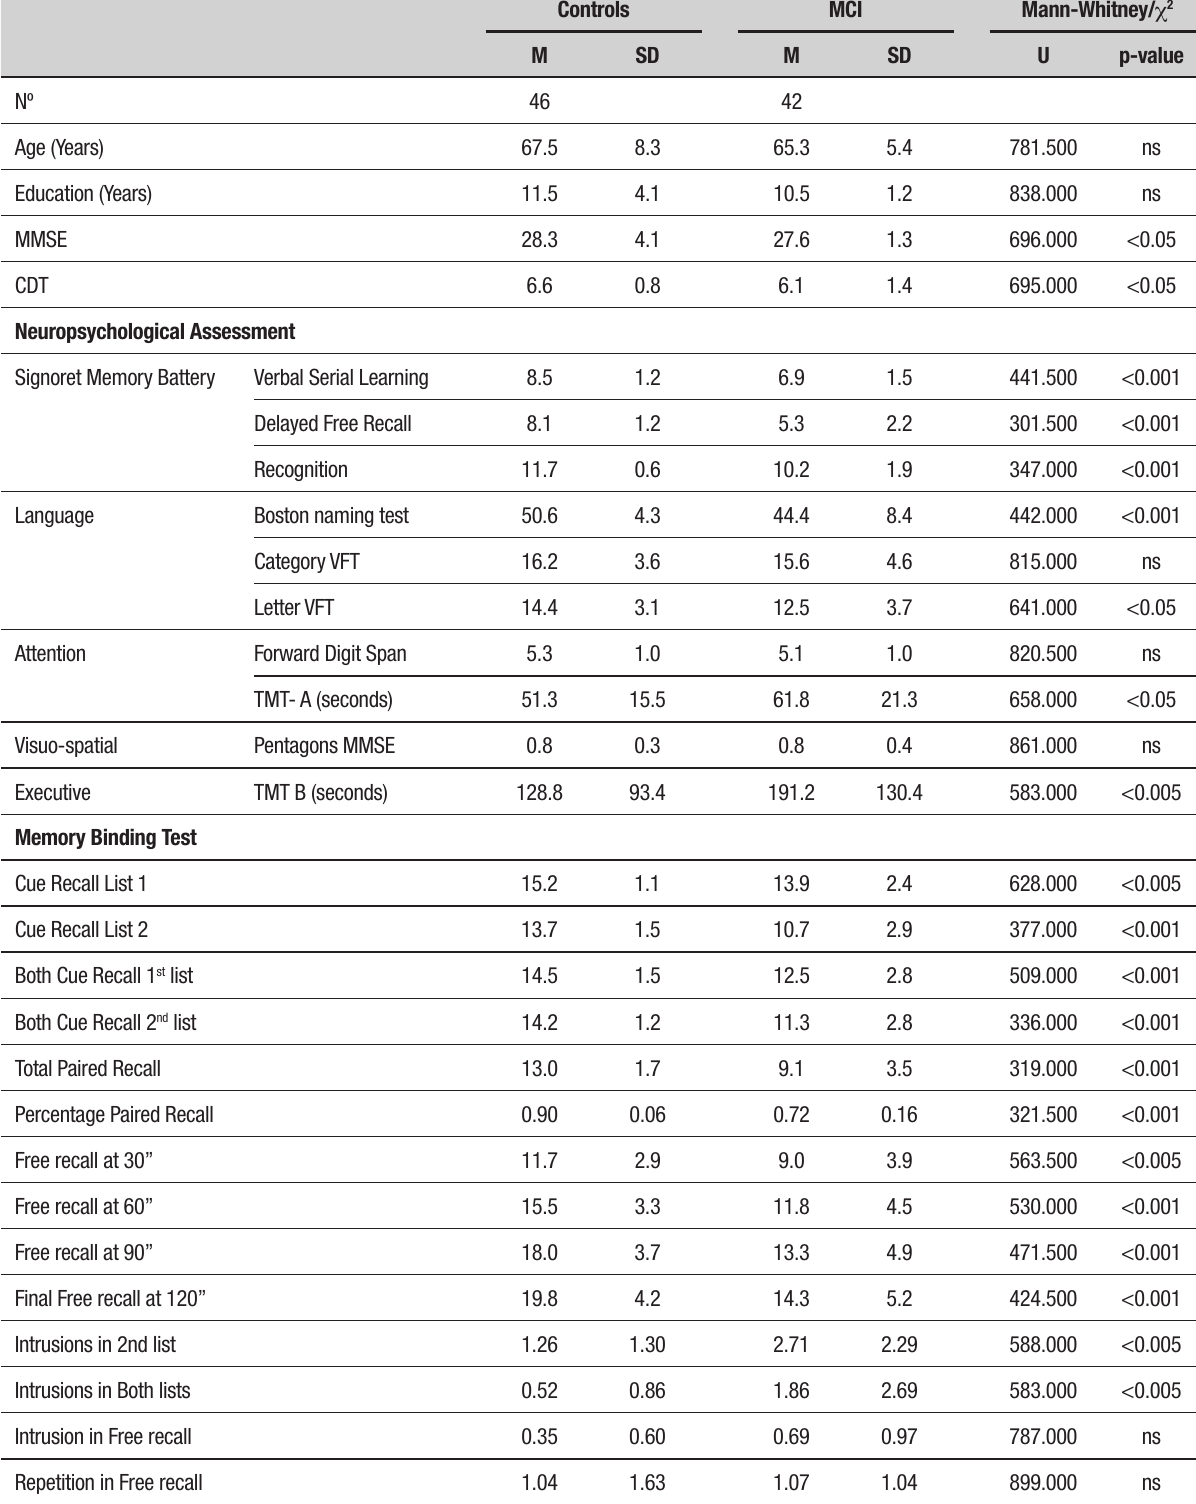
Table 1. Demographic data and neuropsychological